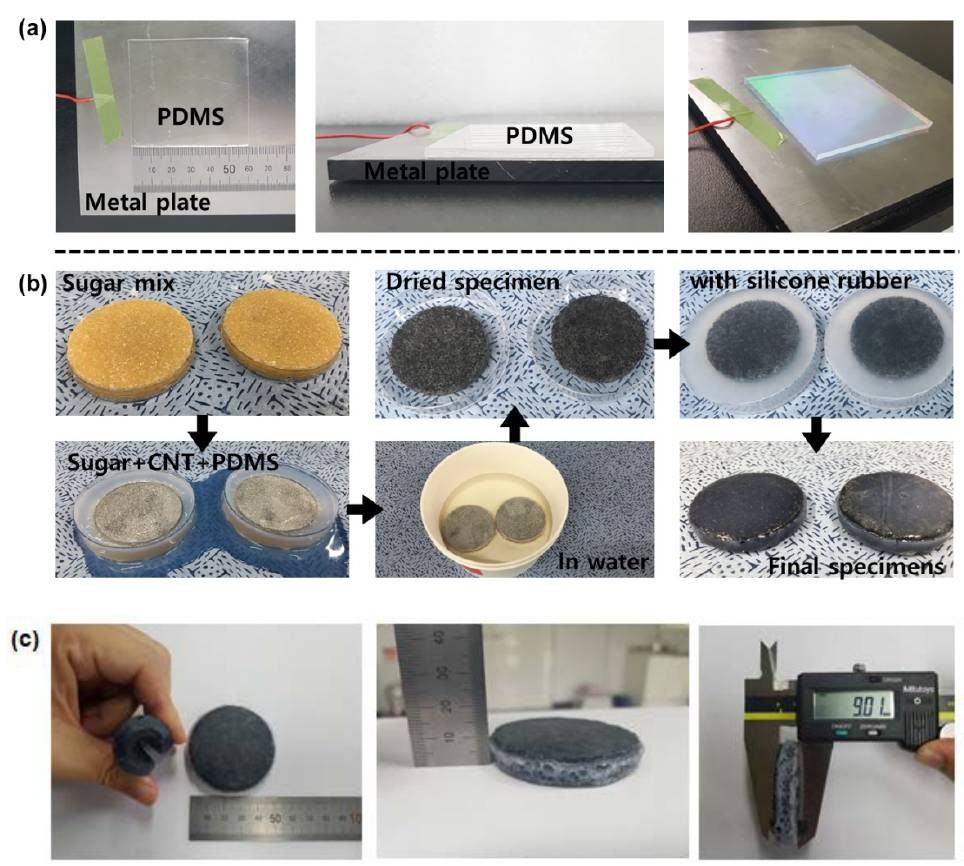
Figure 3. TENG test specimens: ( a ) PDMS-based TENG specimens; ( b ) fabrication process of conductive sponge TENG specimens; ( c ) photos of highly deformable conductive sponge TENG specimens.